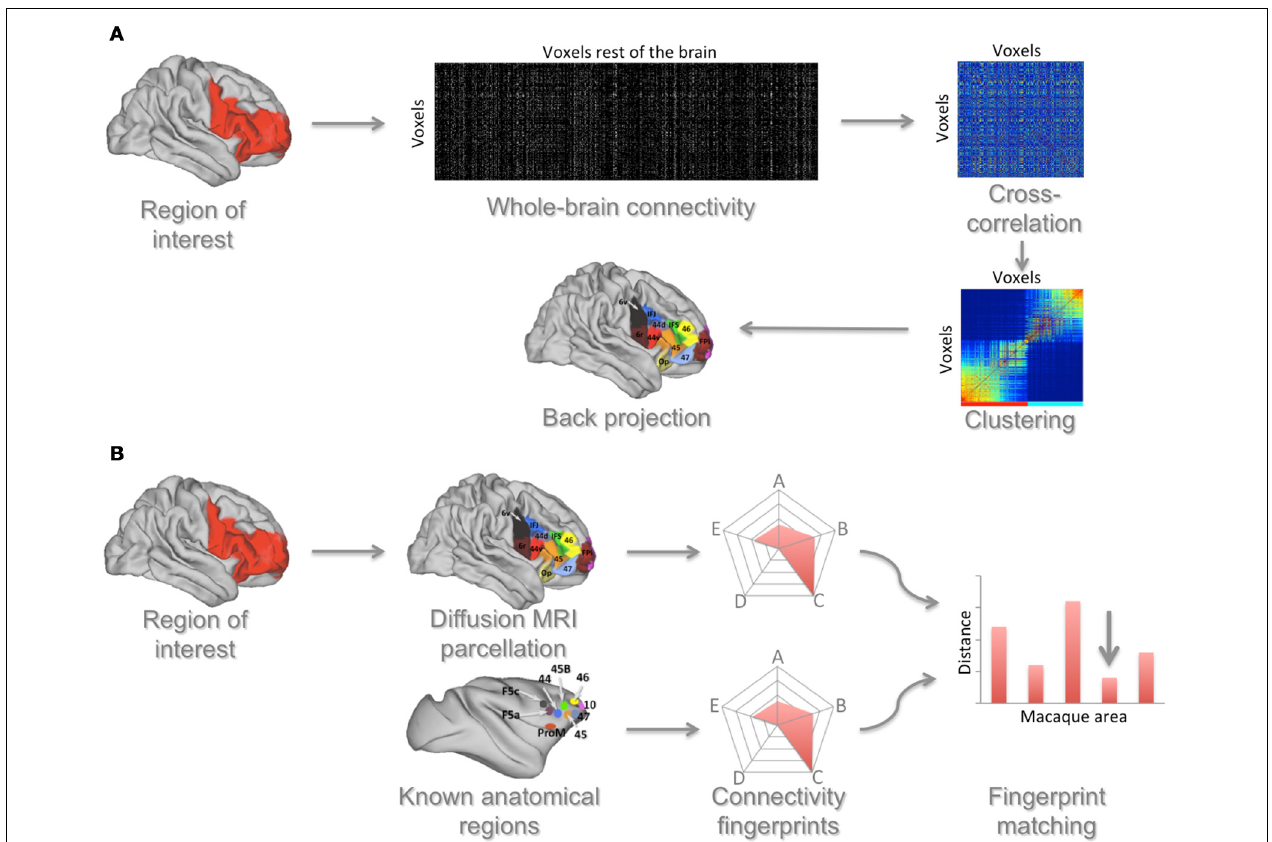
FIGURE 2 | Connectivity-based approach to identifying and comparing brain areas. (A) A region of interest (ROI) is defined and the connectivity of each voxel in this region with each voxel in the rest of the brain is determined. From these data a cross-correlation matrix is calculated that indicates each ROI voxel’s similarity in connections to each other ROI voxel. This matrix is then reordered to group together voxels that have the most similar connectivity profiles. This reordered matrix is then backprojected onto the brain, identifying connectivity-based clusters. Based on Neubert et al. (2014). (B) These areas can then be matched to areas in